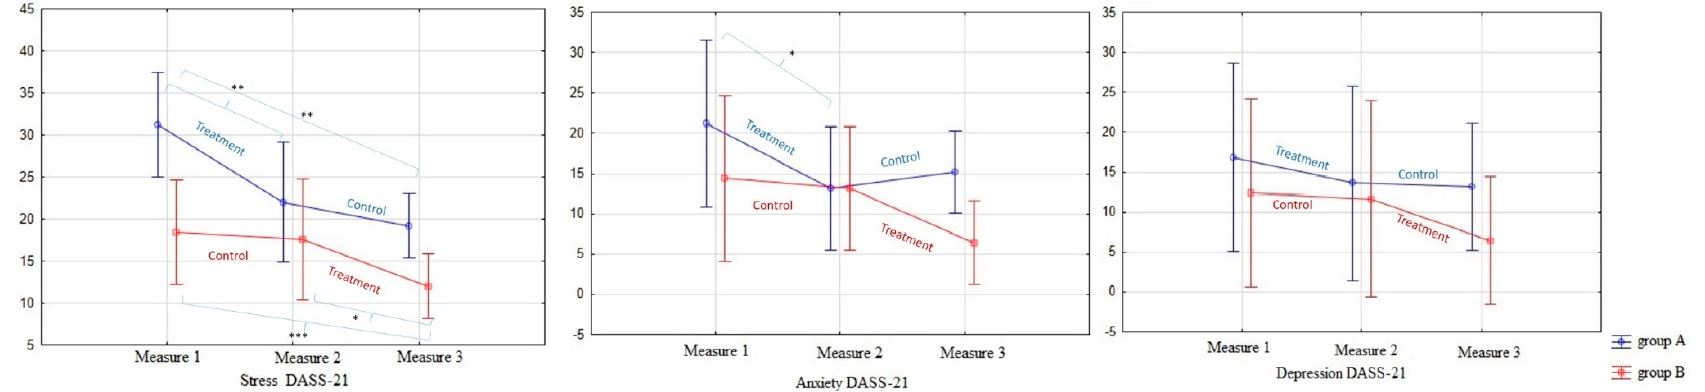
Figure 3. Graphical representation of DASS-21 (Stress, anxiety and depression) residual means with indication of significance of post-hoc differences. (*) p < 0.05; (**) p < 0.01; (***) p <